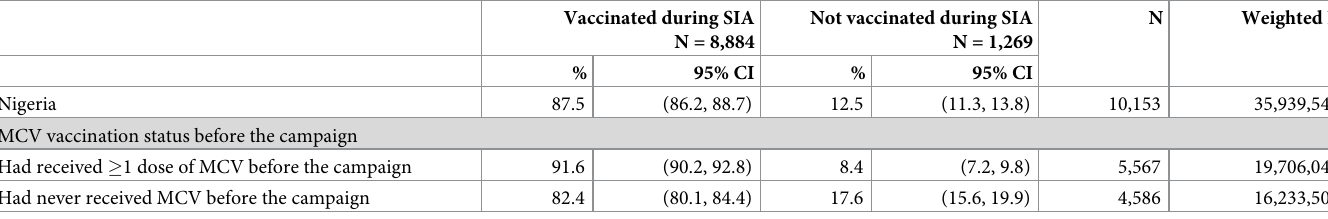
Figs show coverage curves for MCV in Nigeria, the North West zone, and Lagos, respectively. Lagos had the highest proportion of children with HBRs (67.5%) (Fig 1). The North West zone had the highest proportion of early MCV doses among children with HBRs (29.3%) (Fig 4). Table 2. Proportion of children aged 9 months to 59 months who received measles vaccine during the measles campaign, Nigeria PMCCS